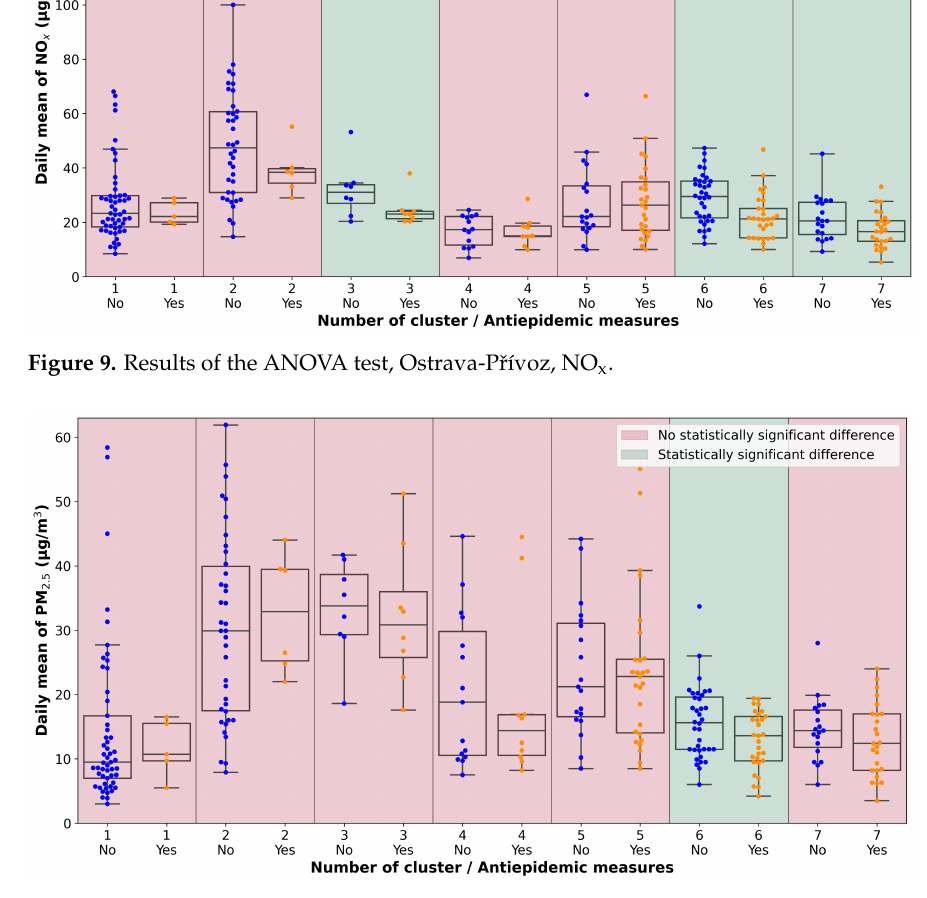
Figure 10. Results of the ANOVA test, Ostrava-Pˇrívoz, PM 2.5